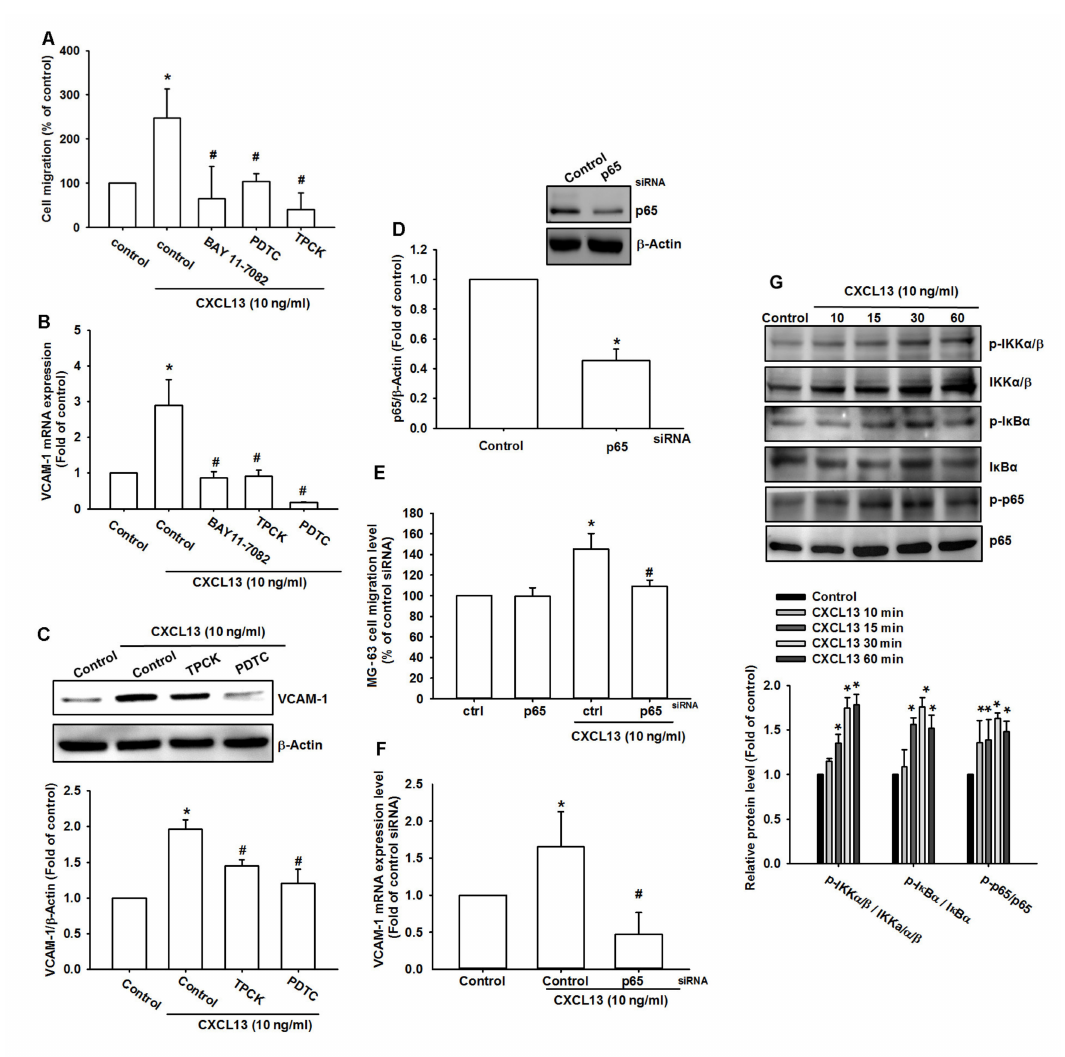
Figure 5. The transcription factor nuclear factor- κ B (NF- κ B) is involved in CXCL13-induced cell migration and VCAM-1 production. MG-63 cells were pretreated with BAY 11-7082, PDTC, or TPCK ( A – C ), or transfected with p65 siRNA ( D – F ), then stimulated with CXCL13; cell migratory potential and VCAM-1 expression was examined by Transwell, qPCR, and Western blot assays. ( G ) MG-63 cells were incubated with CXCL13 for the indicated time intervals, and IKK, I κ B α , and p65 phosphorylation was examined by Western blot. * p < 0.05 compared with the control group; # p < 0.05 compared with the CXCL13-treated